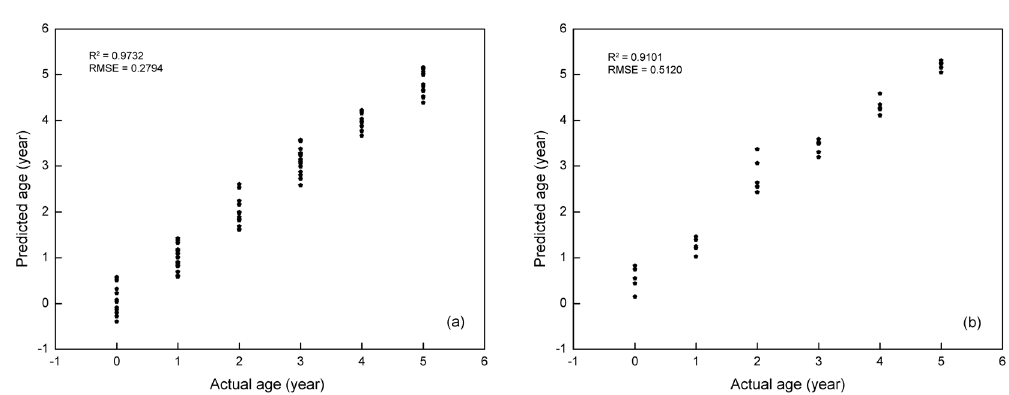
Figure 4. PLSR results for the prediction of liquor age. ( a ): calibration set, ( b ): validation